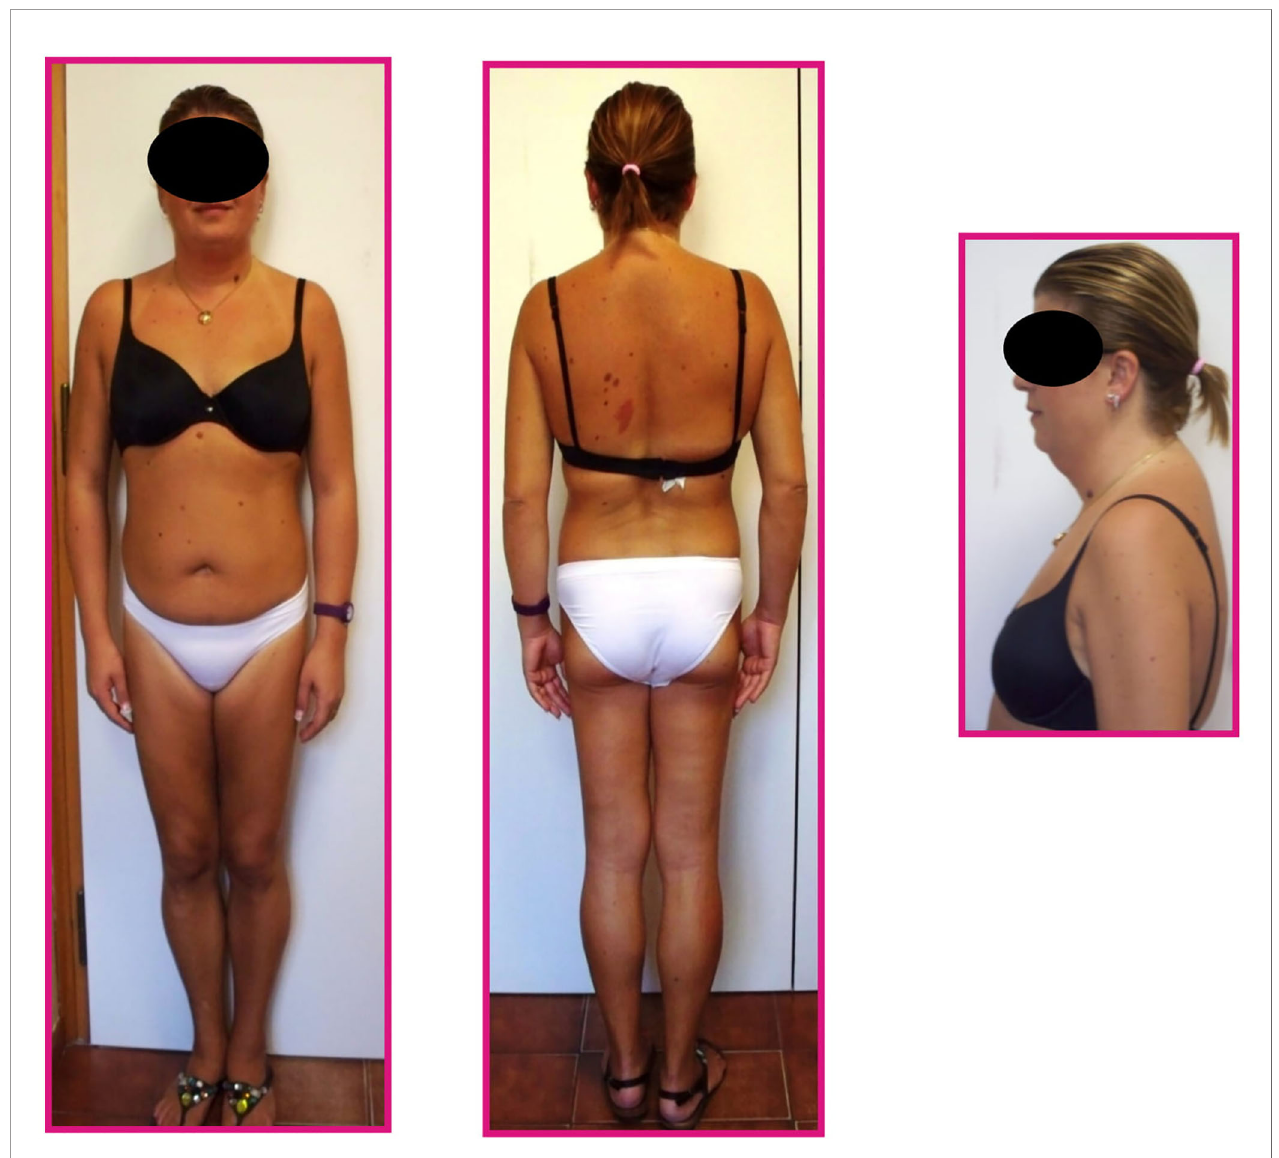
FIGURE 1 | (A) DNA analysis sequencing of the proband by NGS and Sanger sequencing revealed the heterozygous c.604G>A change in LMNA gene. (B) Lamin A and location of probable pathogenic variant identi fi ed in our patient. (C) Alignment of the human lamin A aminoacidic sequence with homologous proteins. The affected amino acid is highlighted in